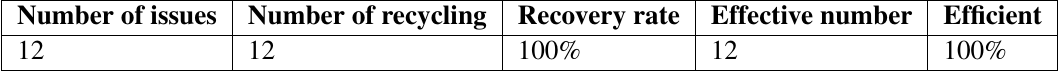
Table 1 Statistics on the distribution and recovery of questionnaires